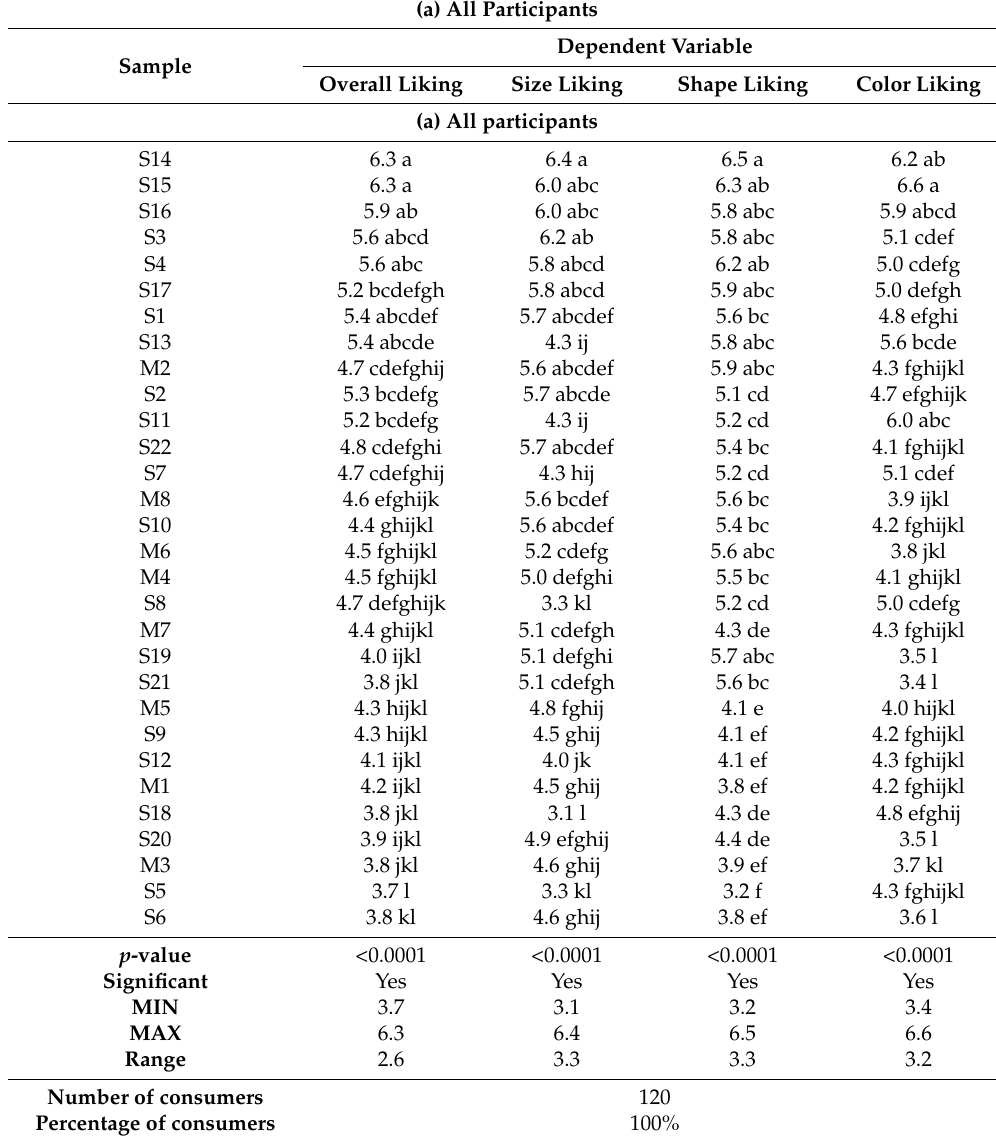
Table A1. Summary of the Tukey’s Honest Significant Difference post-hoc comparison tests for the ANOVA models for all the participants and for each of the three consumer clusters. Overall Liking, Size Liking, Shape Liking and Color Liking as dependent variables. Analysis of Sample as factor for multiple comparisons. A level of significance α = 0.05 was used. For each of the dependent variables, samples not sharing the same letter differ significantly (on each